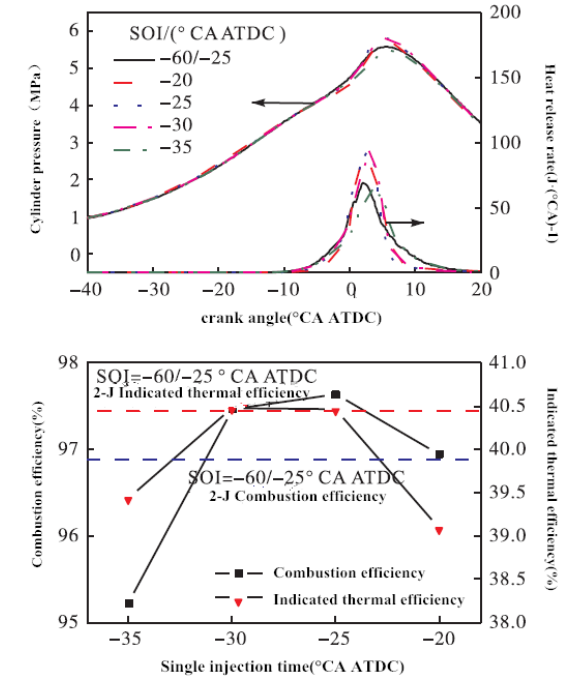
Fig. 16 Effect of single and double injection on combustion at 13 mg/cycle